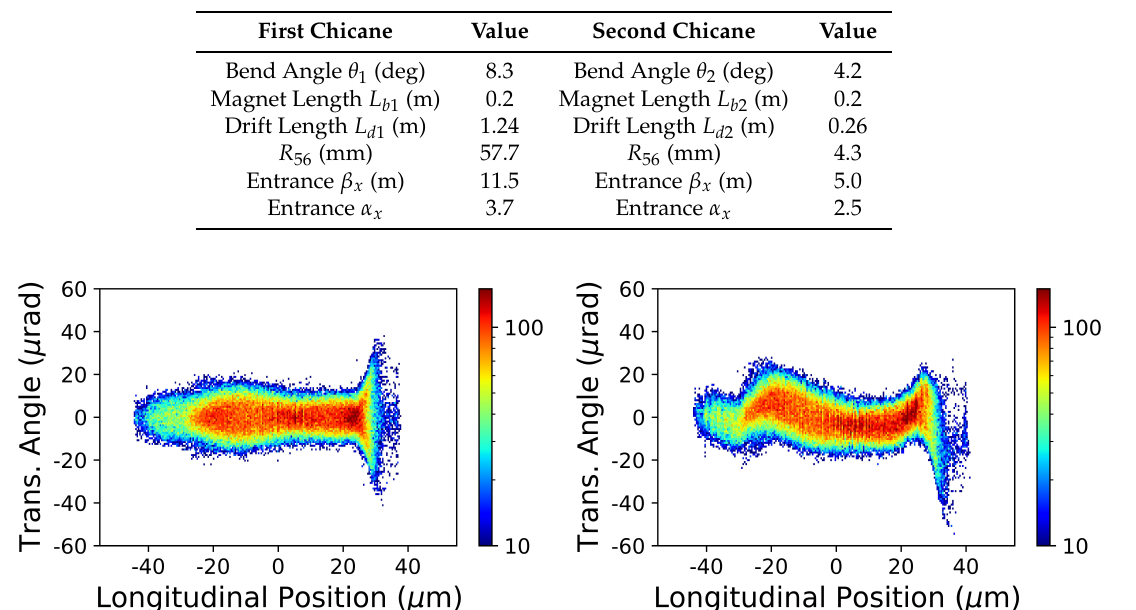
Table 2. The optimal S-chicane parameters for emittance growth cancellation are reported, resulting in the compression by a factor of 20 needed in the first stage. β x and α x refer to the beam Twiss parameters, and the drift length refers to the drifts between the outer bend magnet pairs.